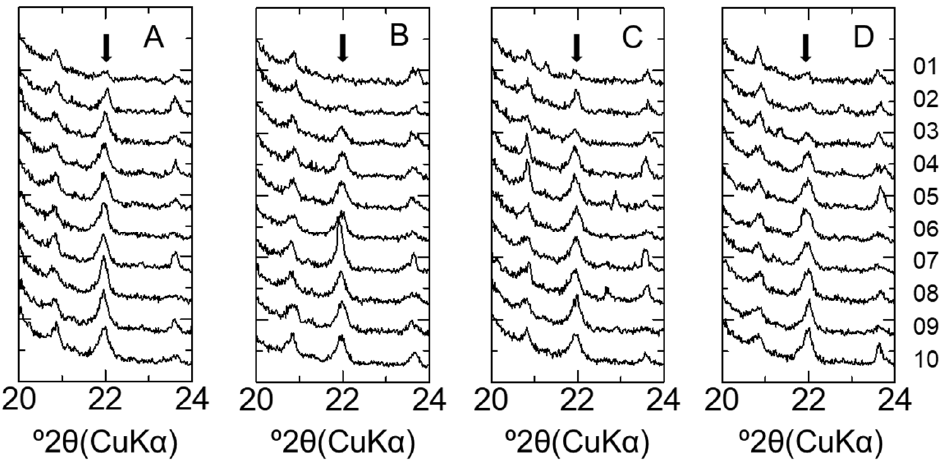
Figure A1. XRD patterns of bentonite in LAC-MX and OPC-MX. ( A ) LAC-MX_4.9 y, ( B ) LAC- MX_10 y, ( C ) OPC-MX_4.9 y, and ( D ) OPC-MX_10 y. Arrows indicate the peak position of cristo-